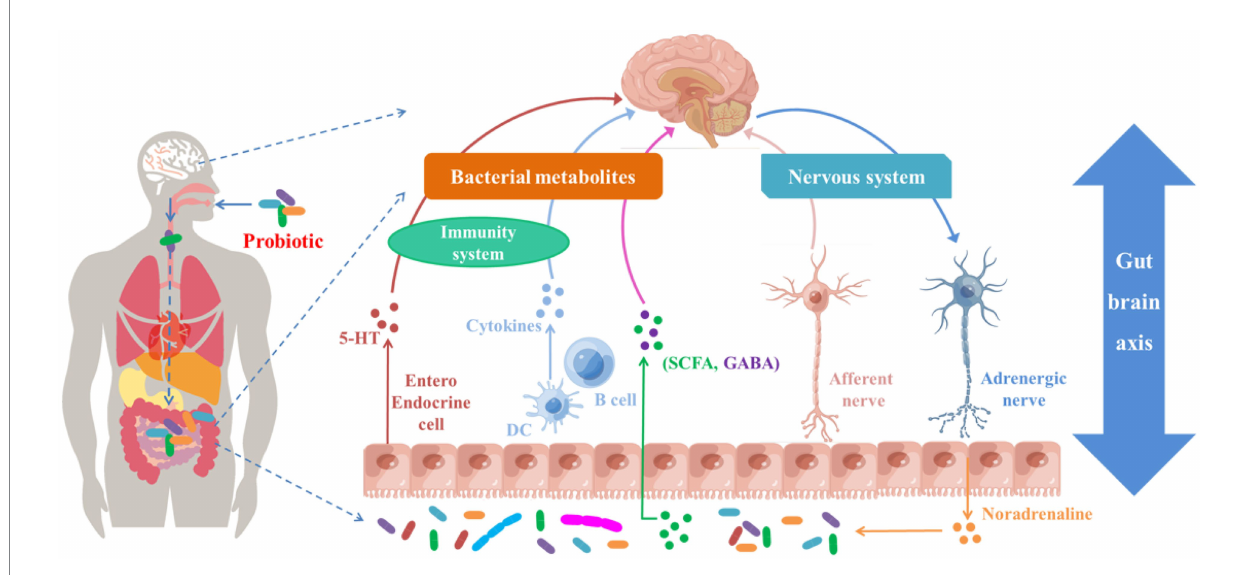
FIGURE 3 Potential ASD treatment responses triggered by probiotics and their metabolites through gut–brain